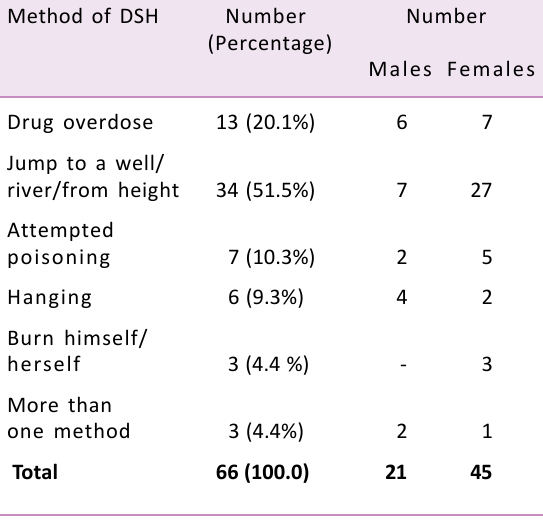
Table 2. Methods used to attempt